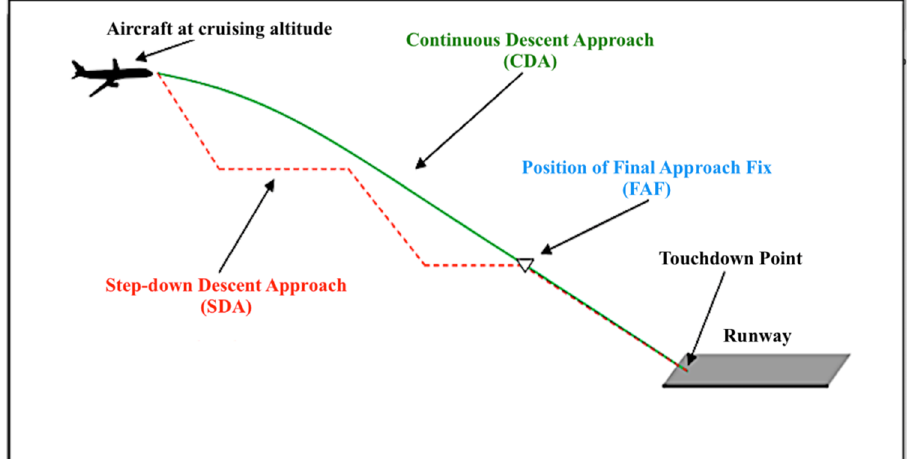
Figure 3. The vertical profile of CDA compared with SDA.